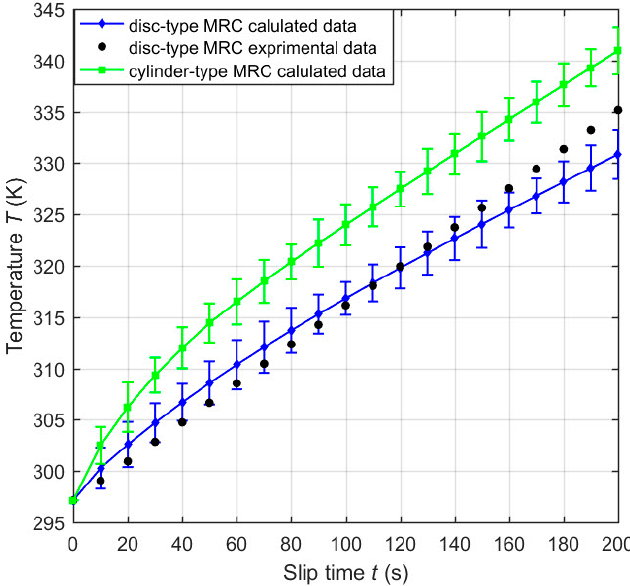
Figure 10. Temperature variations of the working MRFs of the clutches versus the slip time with the comparison of disc ‐ type MRC experimental data